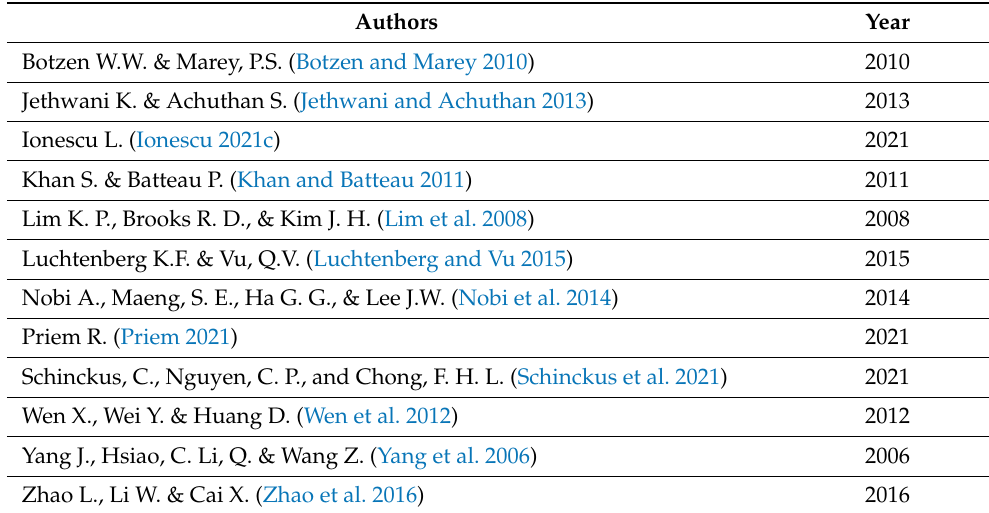
Table 2. Research in the field of the stock market during the